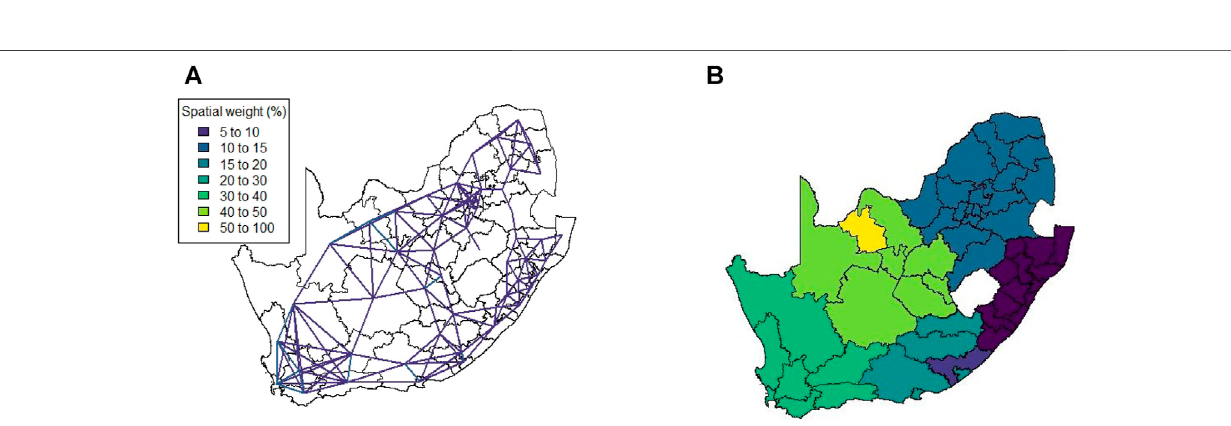
Frontiers in Big Data |